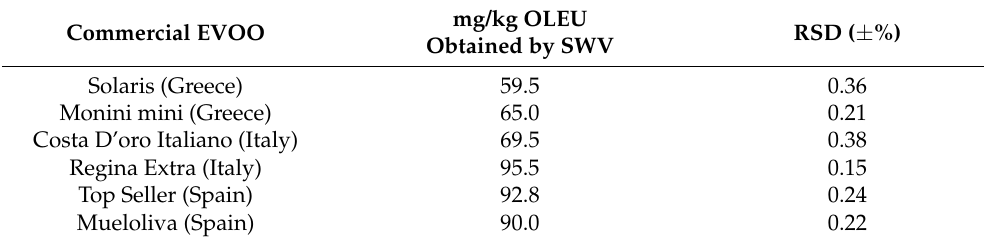
Table 6. Concentrations of OLEU (n = 3) in commercial EVOO obtained by the voltammetric method. Commercial